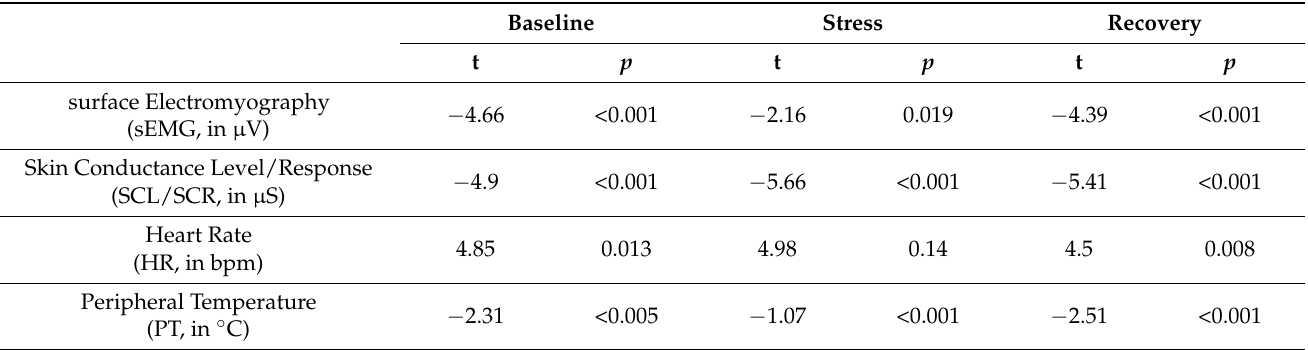
Table 4. Comparison of the average values obtained by patients and controls in the Psychophysiolog- ical Stress Profile (PSP).